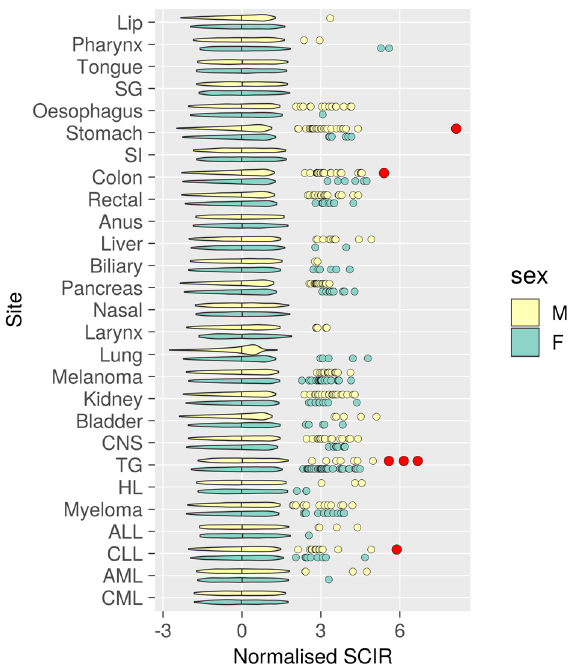
Figure 1. Normalised standardised cumulative incidence ratio (SCIR) estimates of municipality-name-sex combinations. Violin plots for central 95% of normalised SCIRs. MNS combinations allocated to higher risk coefficient group with probability greater than 90% are indicated by dots, with red colour and larger dot size used to emphasise most extreme probabilities (greater than 95%). Sites presented in the same order as in Tables 1 and 2, with abbreviated names. SG salivary glands, SI small intestine, rectal rectum and rectosigmoid, biliary gallbladder and bile ducts, nasal nose and sinuses, larynx larynx and epiglottis, lung lung and trachea, melanoma melanoma of the skin, urinary bladder and urinary tract, CNS brain, meninges, and central nervous system, TG thyroid gland, HL Hodgkin lymphoma, myeloma myeloma and other plasma cell tumours, ALL acute lymphoblastic leukaemia/lymphoma, CLL chronic lymphocytic leukaemia, AML acute myeloid leukaemia, CML chronic myeloid